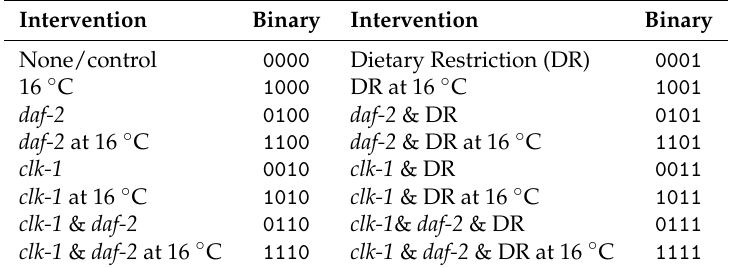
Table 1. Binary representation used to label combinations of longevity interventions in the data set of Yen and Mobbs [10]. Intervention Binary Intervention Binary None/control 0000 Dietary Restriction (DR)